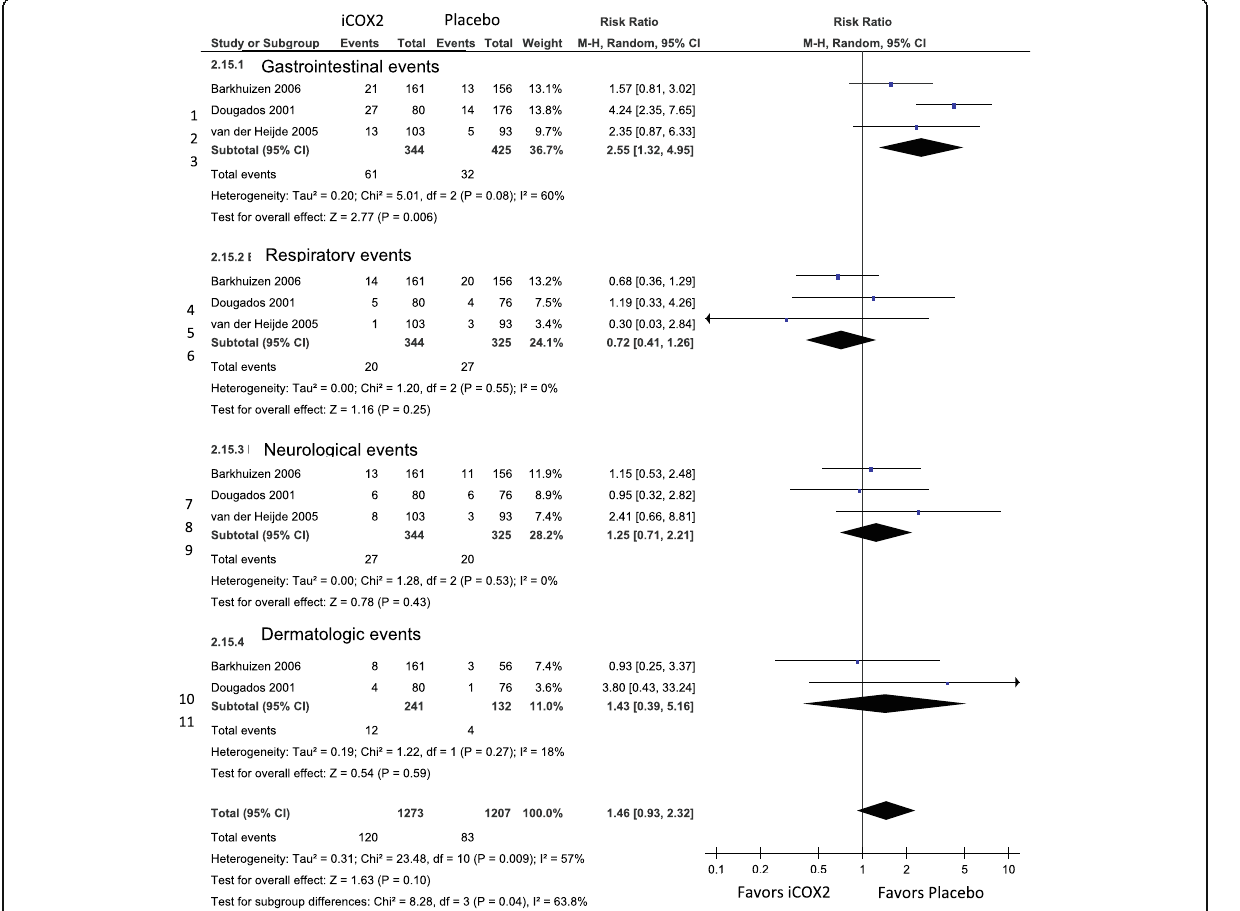
Fig. 8 Incidence of adverse events per organ system in the comparison of selective COX-2 inhibitors versus placebo in patients with ankylosing spondylitis: meta-analysis of three randomized clinical trials. Subtitle: 1) Celecoxib 400mg vs placebo. (2) Celecoxib 200mg vs placebo. (3) Etoricoxib 90mg vs placebo. (4) Celecoxib 400mg vs placebo. (5) Celecoxib 200mg vs placebo. (6) Etoricoxib 90mg vs placebo. (7) Celecoxib 400mg vs placebo. (8) Celecoxib 200mg vs placebo. (9) Etoricoxib 90mg vs placebo. (10) Celecoxib 400mg vs placebo. (11) Celecoxib 200mg vs